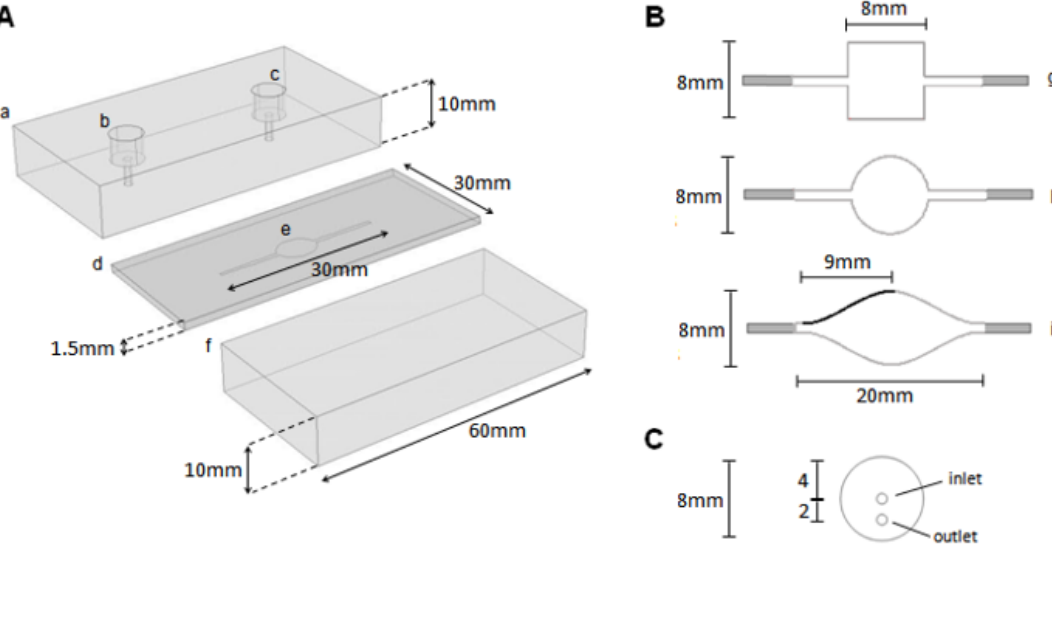
Figure 3. Experimental flow cell construction ( A ): (a) PMMA top block with (b) inlet and (c) outlet holes. Inlet and outlet accommodate ¼ ″ -28 threaded nuts at the top and